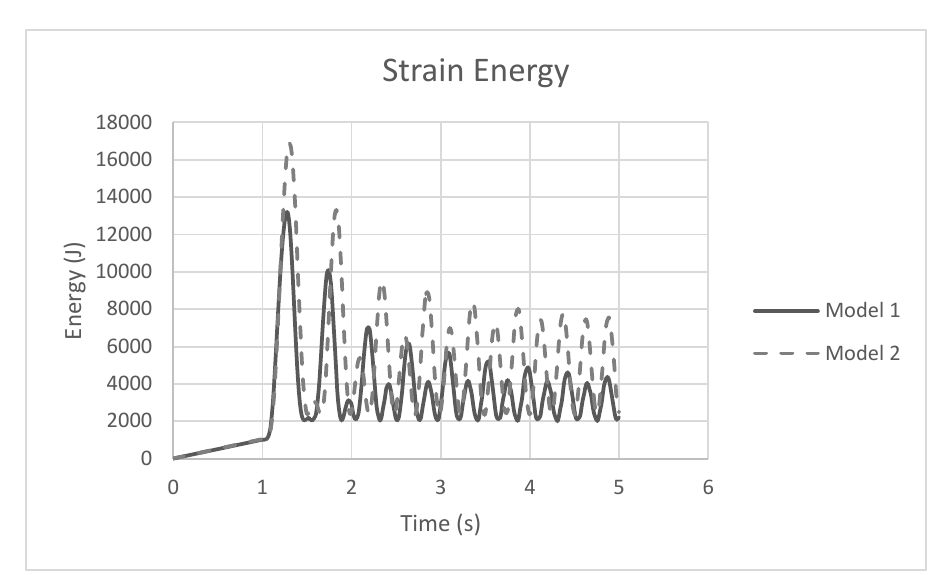
Fig. 12. The recoverable strain energy in the